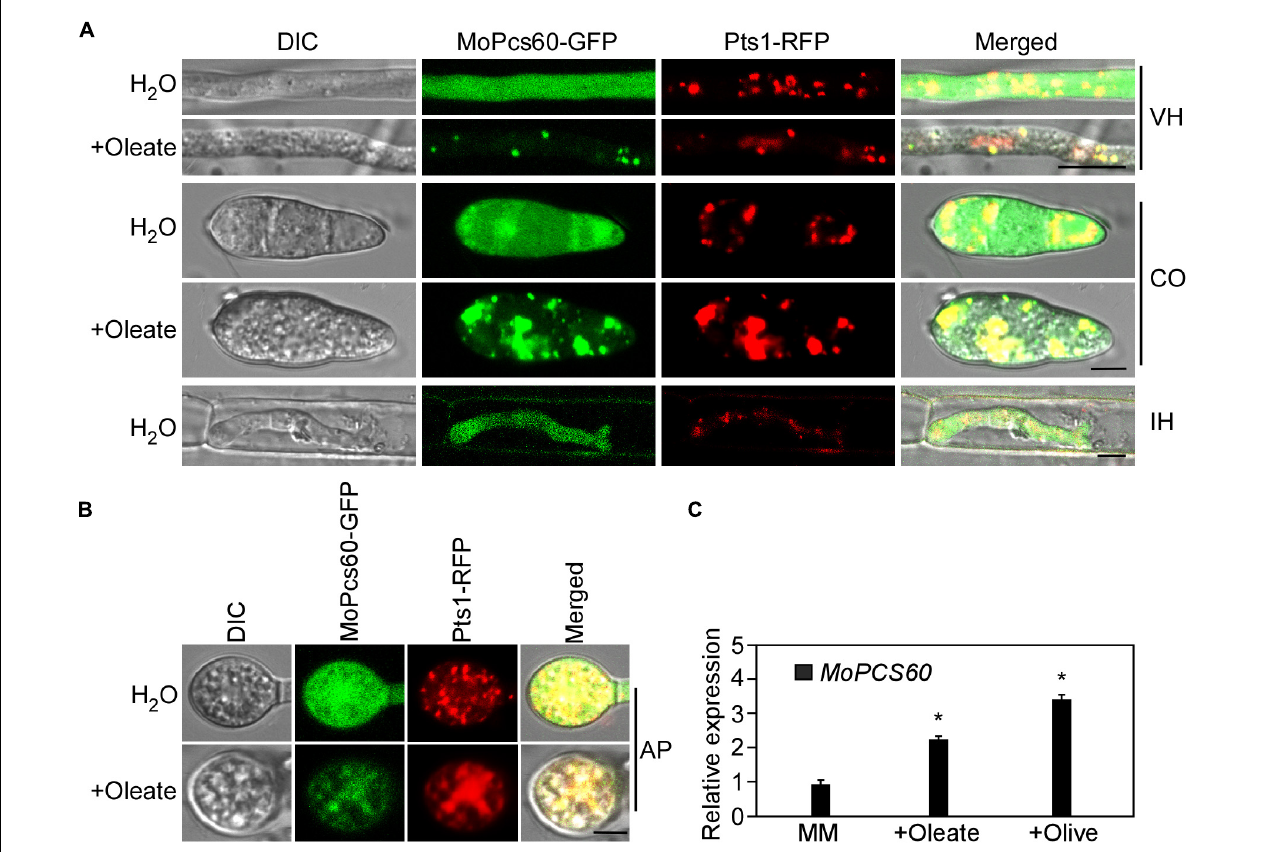
FIGURE 6 | MoPcs60 localizes to peroxisomes under oleate induction. (A,B) Hypha, conidium, invasive hyphae, and appressorium of the MoPCS60-C strain coexpressing MoPCS60 -GFP and RFP-Pts1 with or without oleate treatment were observed under a confocal microscope. VH, vegetative hyphae; CO, conidium; IH, invasive hyphae; AP, appressorium. Bar = 5 µ m. (C) qRT-PCR analyses the expression levels of MoPCS60 in wild-type Guy11 with or without oleate and olive treatment. Error bars are standard deviations from three biological repeats, and asterisk represents significant difference (* p <